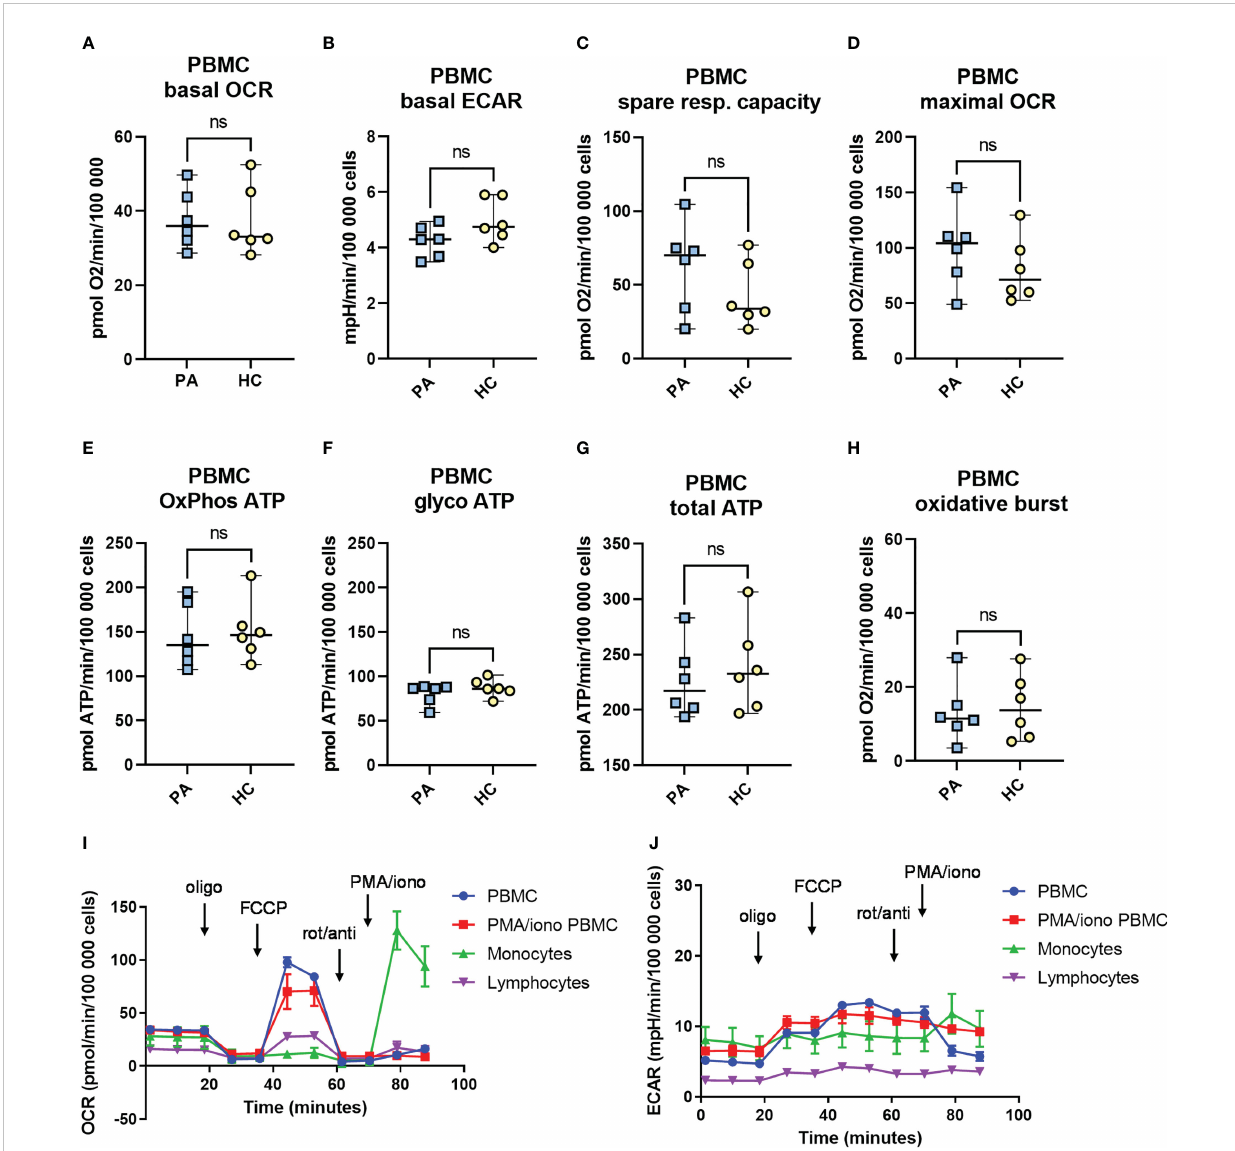
FIGURE 5 The metabolic pro fi le and mitochondrial function in peripheral blood mononuclear cells (PBMCs) from patients with MIS-C in convalescent phase. Metabolic pro fi le of PBMCs of healthy controls (HC, n = 6), and convalescent MIS-C patients (PA, n = 6) was determined with Seahorse XFe24 analyzer. PBMCs were isolated and seeded in a Seahorse plates. The oxygen consumption rate (OCR) (A) and extracellular acidi fi cation rate (ECAR) (B) were measured in real time under basal conditions, and in response to the injection of the following inhibitors: oligomycin (Oligo, 1.5 m M), cyanide ‐ 4 ‐ (tri fl uoromethoxy) phenylhydrazone (FCCP, 2 m M), rotenone plus antimycin-A (rot/anti, 0.5 m M) and to PMA/ionomycin (PMA/Iono, 1 m g/ ml) to measure oxidative burst. The spare mitochondrial capacity (C) and maximal respiration - maximal OCR (D) were determined according to Mito Stress Assay, OxPhos ATP (E) , glycoATP (F) and total ATP (G) were calculated from OCR and ECAR measurements as de fi ned in M&M. The oxidative burst (H) was measured after last injection with PMA/ionomycin (1 m g/ml). Data are presented as median with 95%CI and analyzed by Mann-Whitney test ns, not signi fi cant. (I, J) Representative time-course measurements of OCR and ECAR and the injection